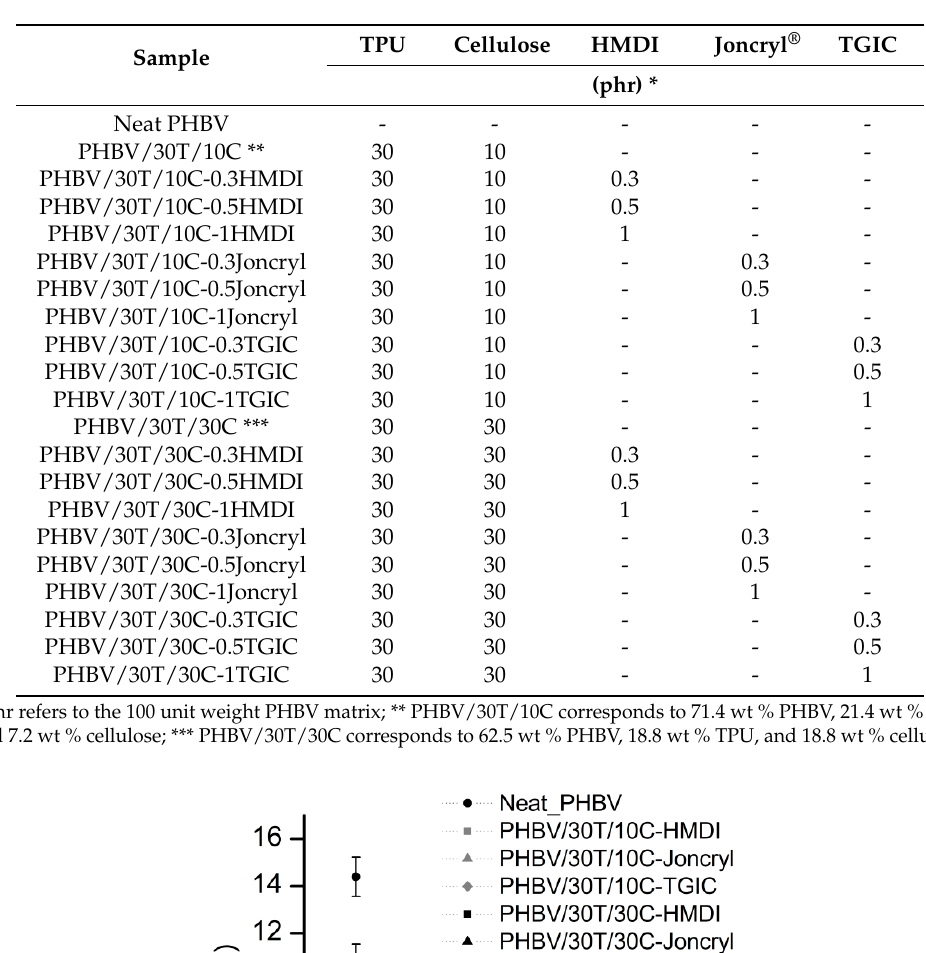
Table 1. List of compounds and their composition.